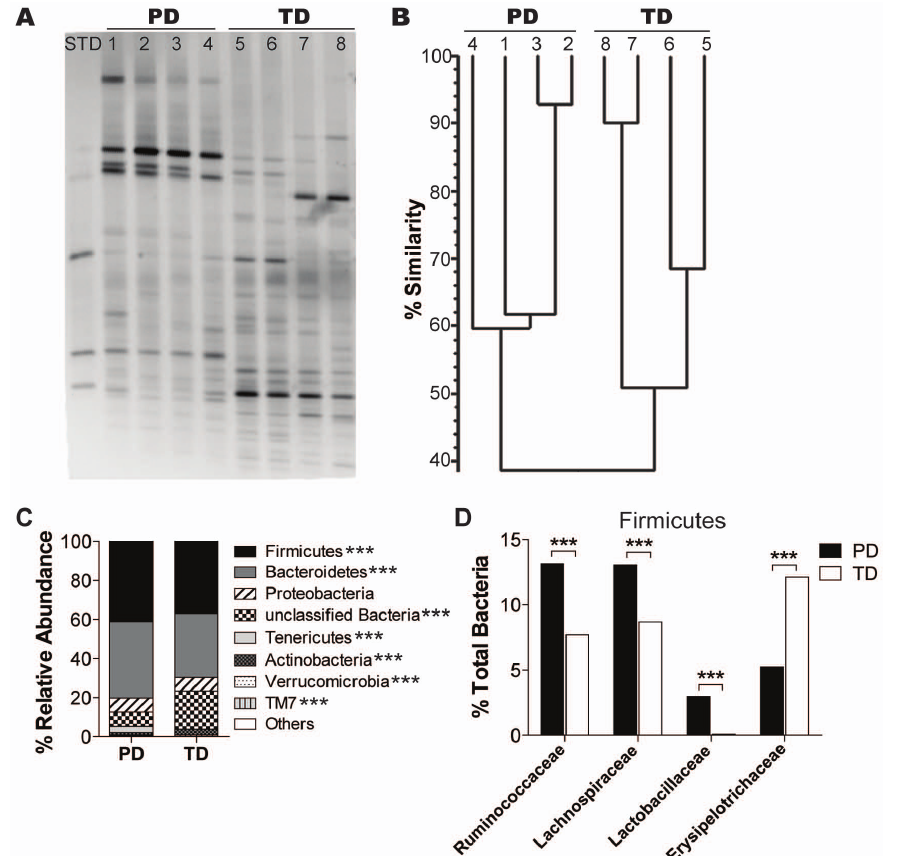
Figure 3. Diet-mediated effects on fecal microflora. (A) DGGE fingerprints of fecal DNA from the PD-fed (lanes 1–4) and TD-fed mice (lanes 5–8) (n=4 mice/group). Data shown is one representative of three independent experiments. (B) Cluster analysis showing the similarity measurements of the DGGE banding patterns shown in panel A. (C) Metagenomic analysis showing the abundance of bacterial phyla present in feces from PD- and TD- fed mice (n=2 mice/group). (D) Abundance of bacterial families in Firmicutes phylum present in feces from PD- and TD-fed mice (n=2 mice/group). Significant difference was found in multiple bacterial phyla and families between PD and TD (***P , 0.0001, Pearson Chi-Square Goodness of Fit test). DGGE, denaturing gradient gel electrophoresis; PD, purified diet; TD, Teklad